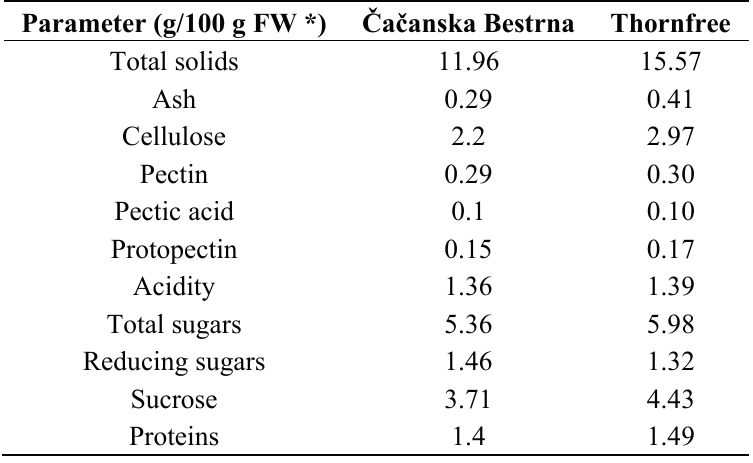
Table 7. Chemical composition of two blackberry cultivars grown in Serbia